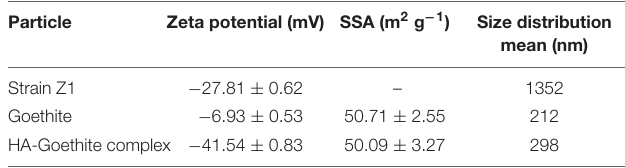
TABLE 1 | Zeta potential, SSA, and size of bacteria cell and